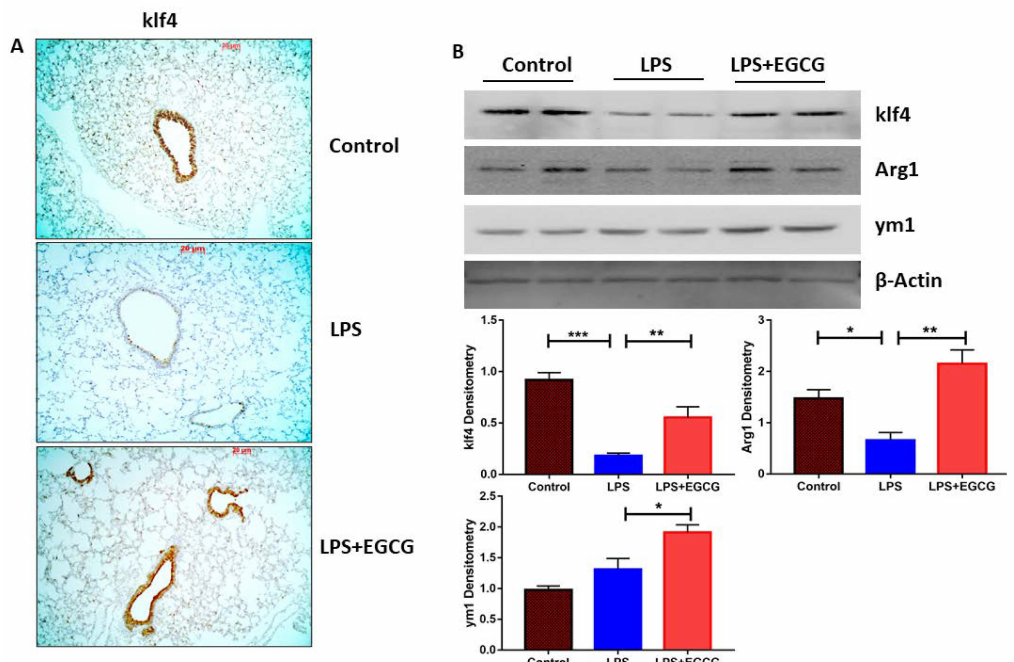
Figure 5. EGCG-induced lung microenvironment towards M2 in LPS-induced ALI. ( A ) The lung KLF4 protein expression shown by immunohistochemistry in the di ff erent study groups (10 × objective). EGCG treatment caused enhanced expression of lung KLF4 in LPS(IT)-induced ALI mice. ( B ) Western blot of di ff erent lung injury groups was performed to evaluate M2 polarisation markers including Arg1, ym1 and KLF4. Actin was used in parallel as internal control. Significant di ff erence * p < 0.05, ** p < 0.01 and *** p <